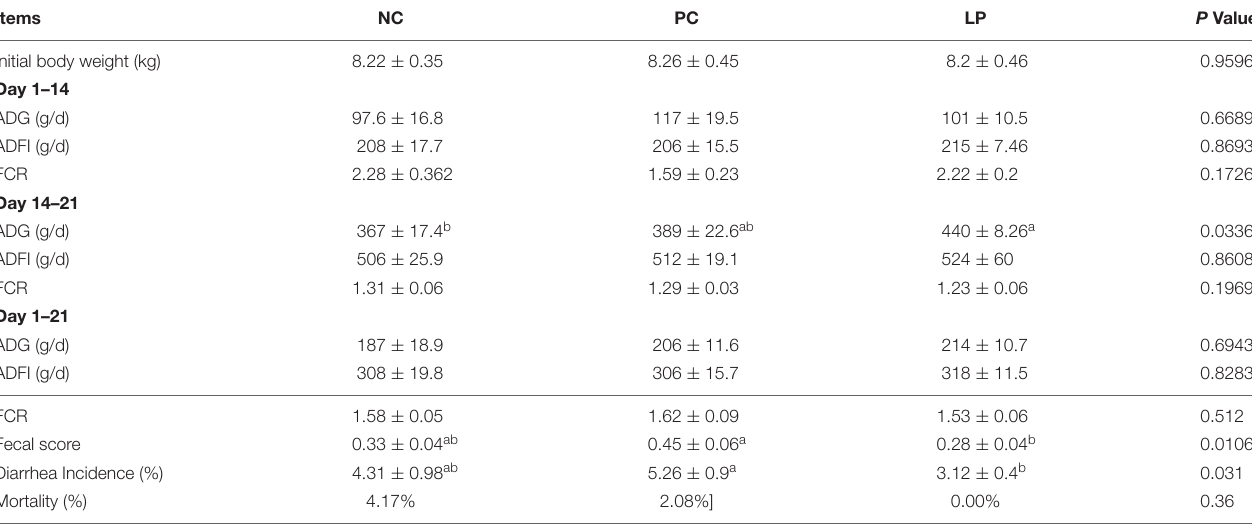
TABLE 1 | Effects of probiotics and antibiotics on weaning piglet performance, diarrhea incidence, and mortality. Items NC